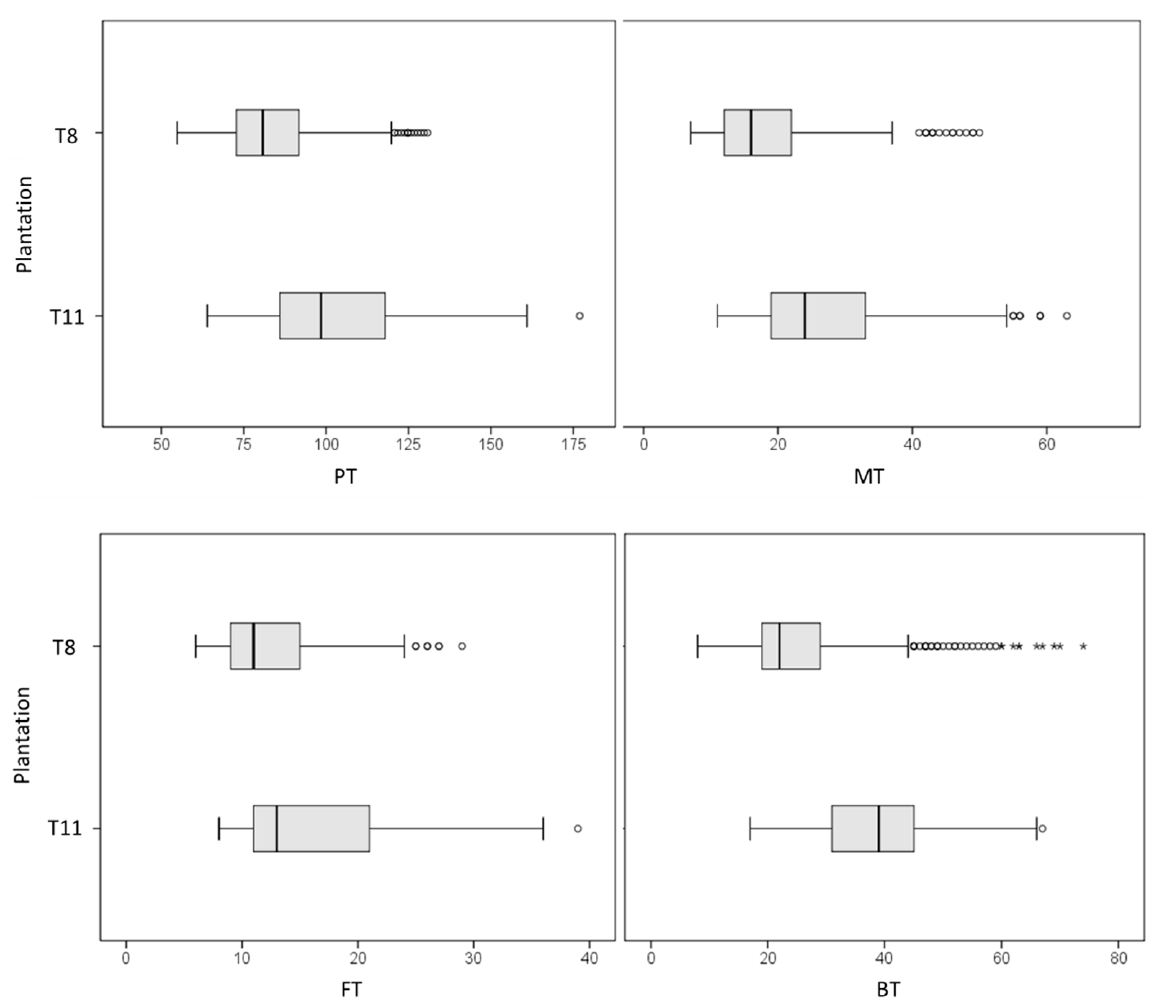
Figure 5. Box plots showing the comparison of PT (productive work time), MT (moving time), FT (felling time), and BT (bunching time) distributions in plantations T8 and T11 (in s tree − 1